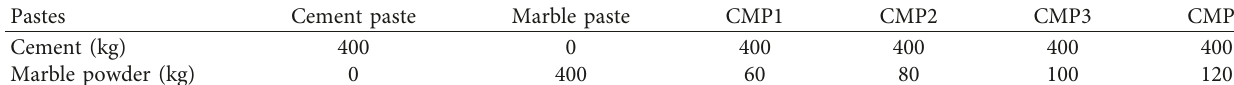
Table 9: Composition of the different pastes